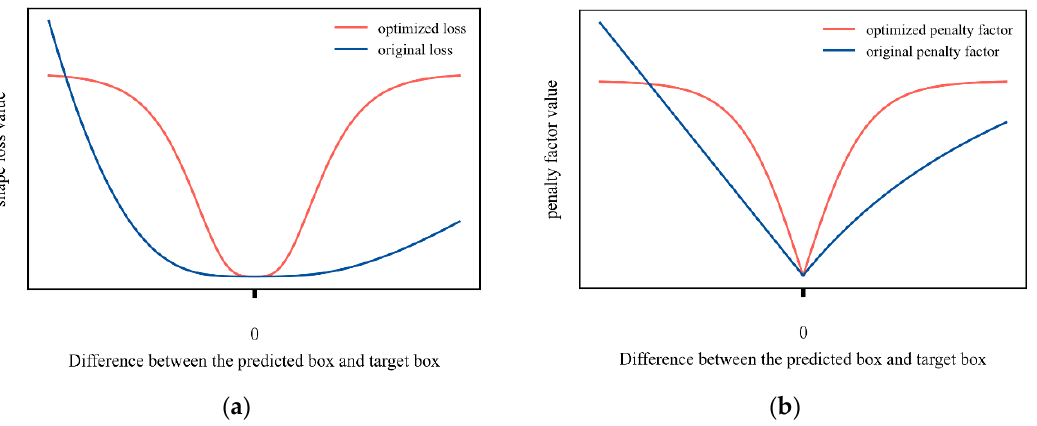
Figure 8. Comparison of shape loss and normalized penalty factor before and after improvement. ( a ) Shape loss; ( b ) normalized penalty